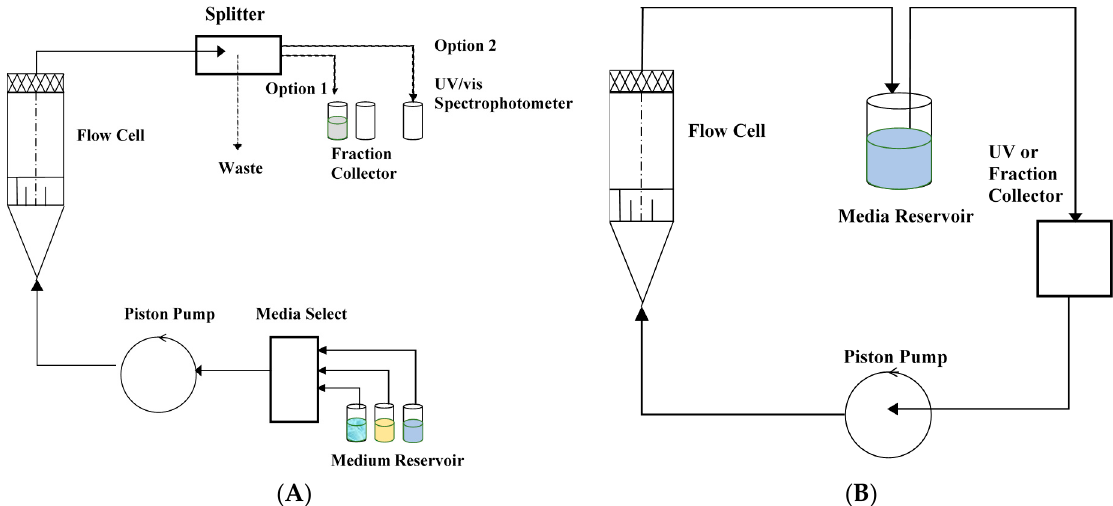
Figure 9. Sketch of a USP 4 flow-through system showing open loop ( A ) and closed loop ( B ) configurations.